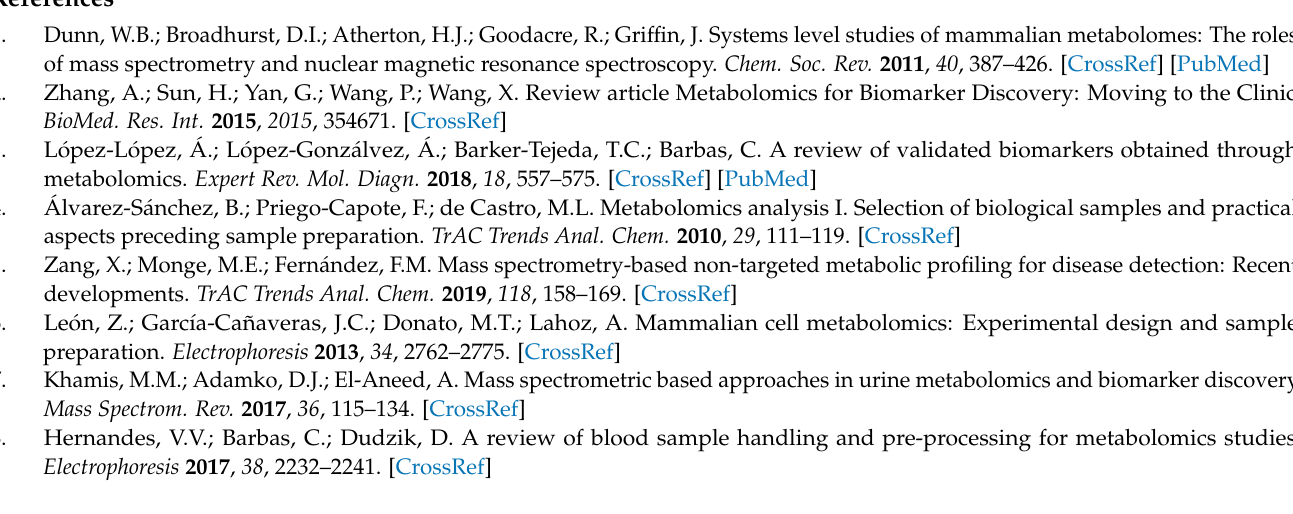
Table S2: Blood plasma study data, Table S3: Urine study data, Table S4: Saliva study data, Table S5: Breath study data, Table S6: Muscle study data. Rhythmic/gradient metabolite lists organised by subtheme, Table S7: Circadian, Table S8: Sleep deprivation, Table S9: Sex differences, Table S10. Shift work, Table S11: Health, Table S12. Diet